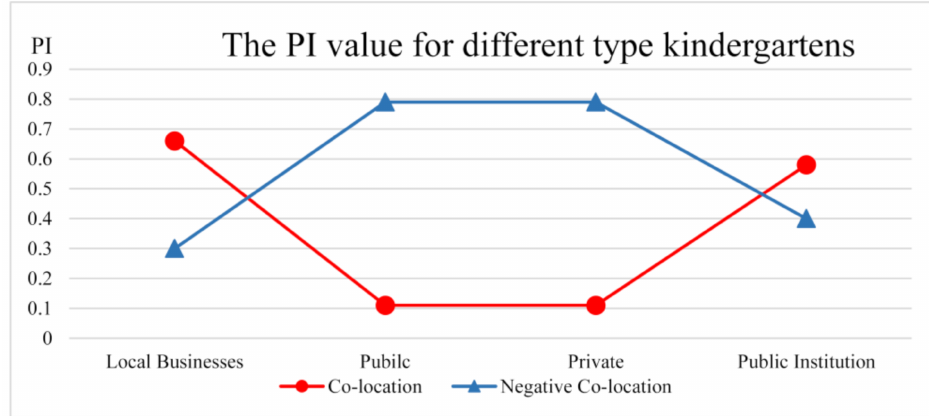
Figure 12. Different school types of the value of